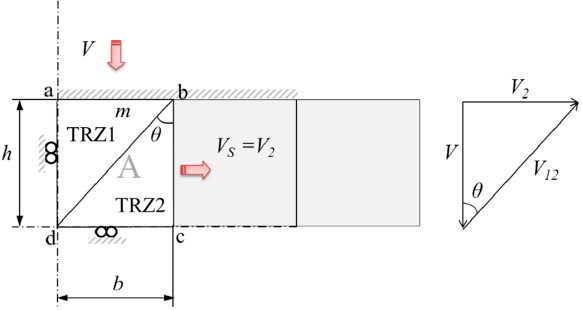
Figure 2. Module A analysis and velocity hodograph.